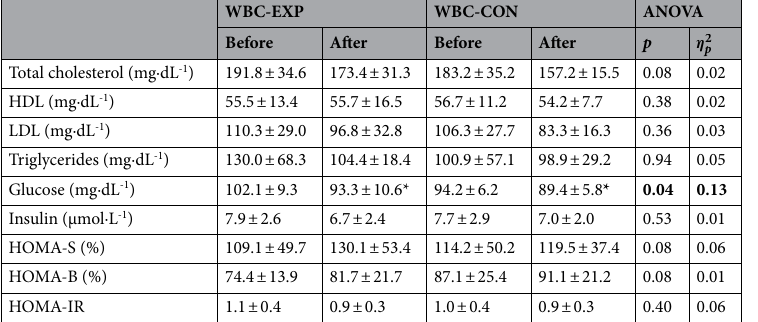
2 p - effect sizes (partial eta